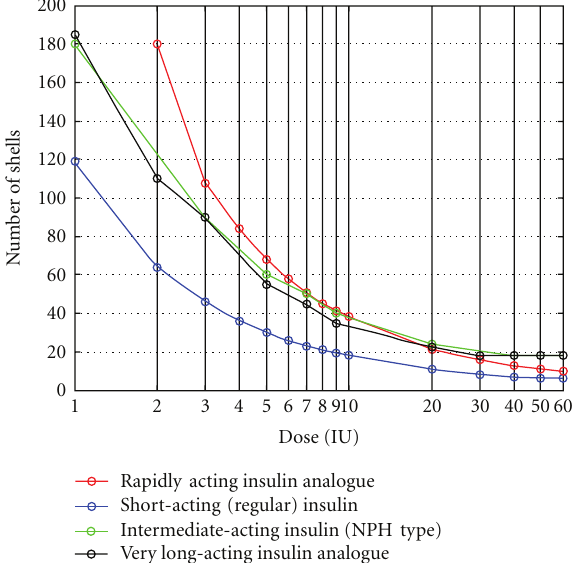
Figure 5: A bench test study concerning spatial discretization reveals that a fixed number of shells is not appropriate for any insulin class, dosage, or preparation. Accurate simulation results depend on the insulin preparation and the dose. The number of shells required for an insulin absorption profile computation with an area under the curve (AUC) error below 1% is shown. The time step considered for 2 IU of rapidly acting insulin was reduced to 0.002 to avoid numerical instabilities. The value for 1IU could not be computed due to memory resources limitations (number of shells greater than 250 are